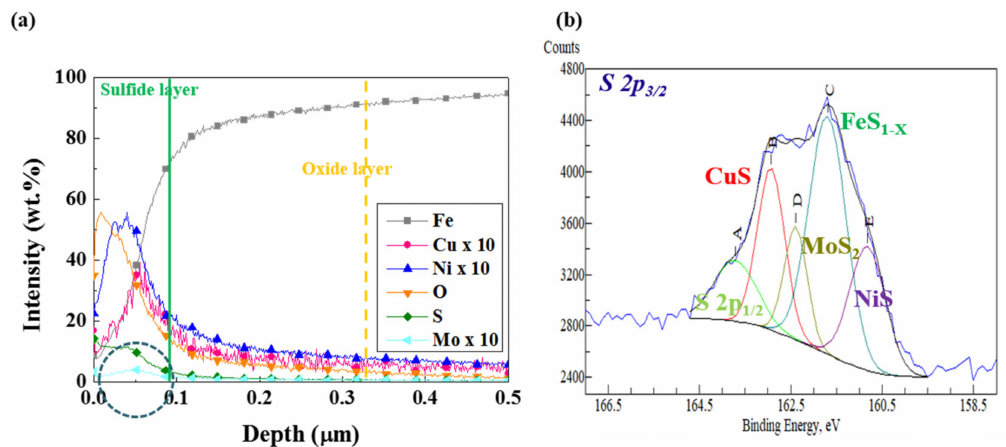
Figure 14. ( a ) GDS analysis, and ( b ) XPS analysis of the corrosion product layer formed on Steel C after the immersion test in a NACE solution with 0.05 M Na 2 S for four